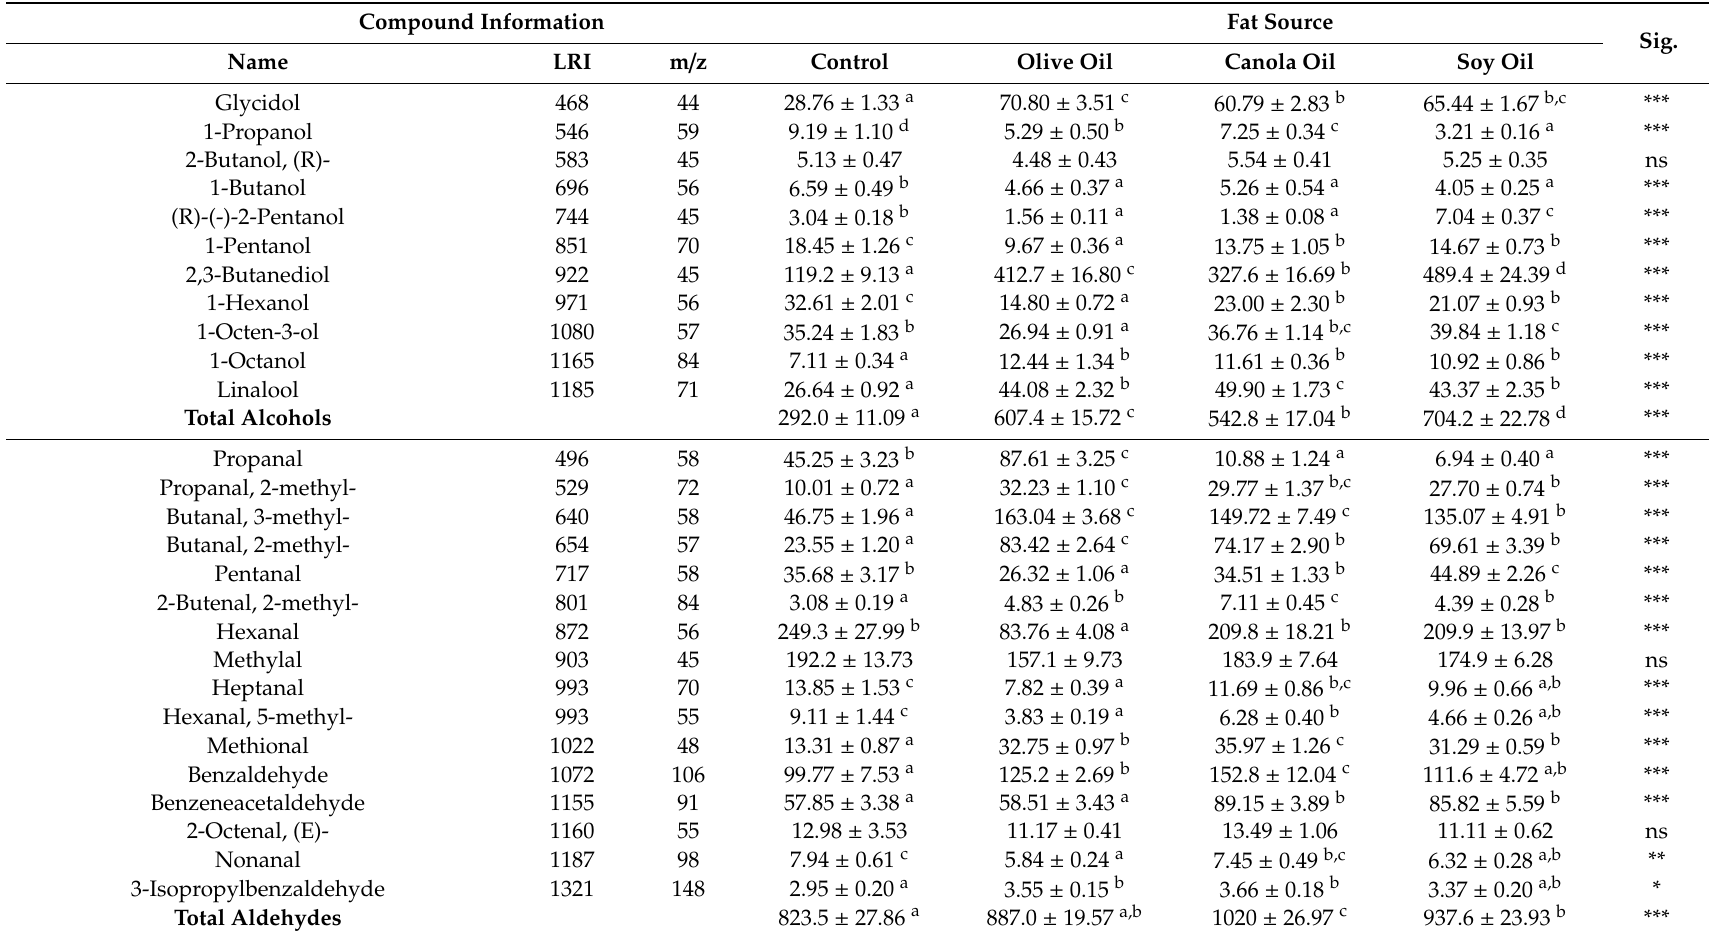
Table 4. E ff ect of fat source on volatile compounds (expressed as AU · 10 4 / g) of dry-fermented deer